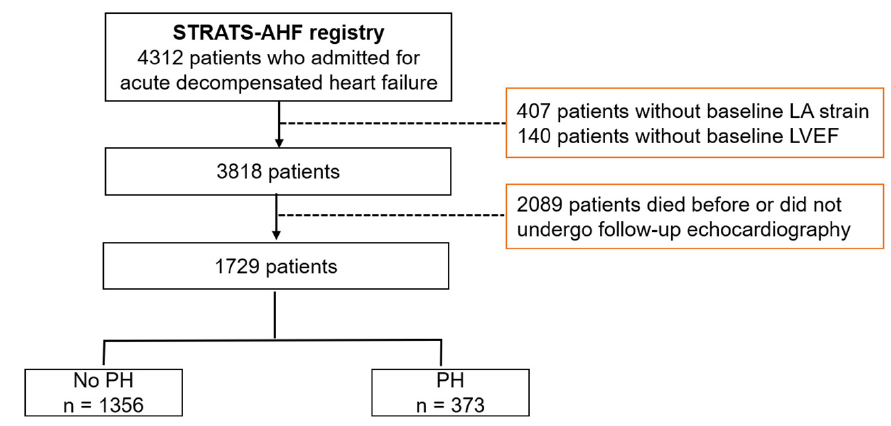
Figure 1. Study scheme. LA: left atrium, LVEF: left ventricular ejection fraction, PH: pulmonary hypertension, STRATS-AHF: STrain for Risk Assessment and Therapeutic Strategies in patients with Acute Heart Failure.